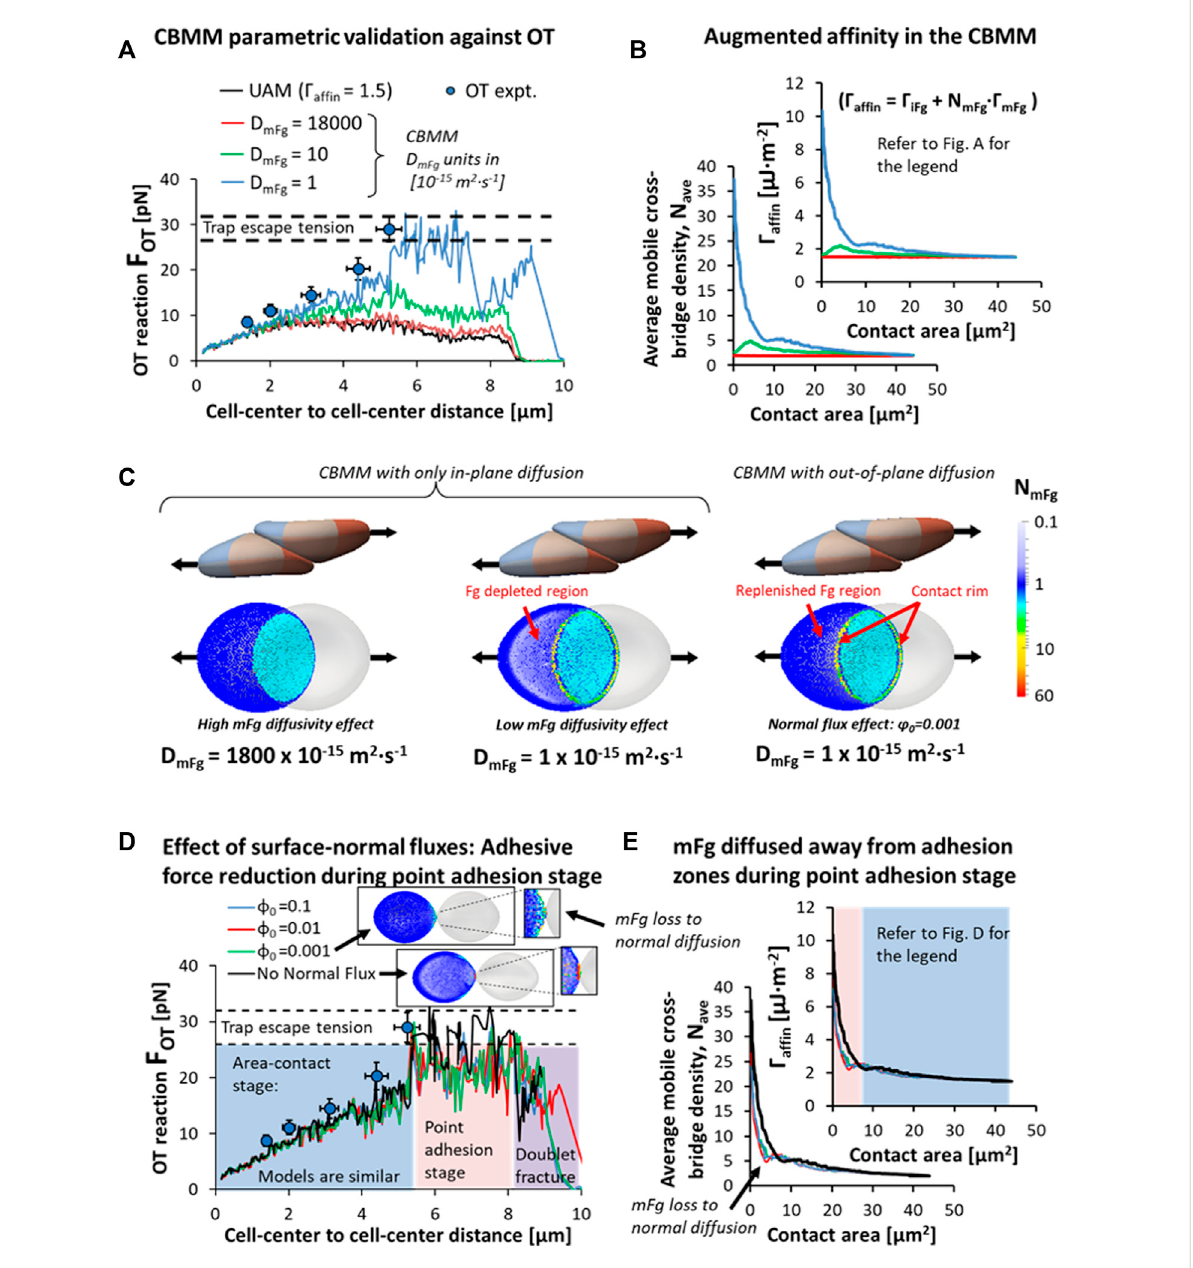
FIGURE 6 Validation of CBMM against RBC-doublet disaggregation optical tweezers (OT) experiments. (A) Comparison of the cross-bridge migration model (CBMM) under varying mFg diffusivity, DmFg [1x10 − 15 m 2 · s-1] against the experimental results. (B) Augmented surface af fi nity of the RBC doublet adhesion due to an increase in the average cross-bridge density in the intercellular gap prescribed by convection-diffusion mechanisms in theCBMM. (C) Distributionmapsofsurface-adsorbedFgduringdoubletdisaggregationpredictedbytheparametricsimulationstudy.HighmFg diffusivity effect: Fast lateral diffusion of mFg ensured homogenous mFg distribution. Low mFg diffusivity effect: Slow rate of mFg diffusion allowed frictional drifttoaccumulate mFgincontactrim;Normal fl uxeffect:Depleted regionswerereplenished byout-of-planediffusion(Simulation movie in SM5). (D,E) Models with surface-normal diffusion under varying resting bulk to surface concentration ratios ( ϕ 0 ) indicated mFg loss and adhesion weakening only during point-adhesion stage, prior to doublet fracture (Simulation movie in